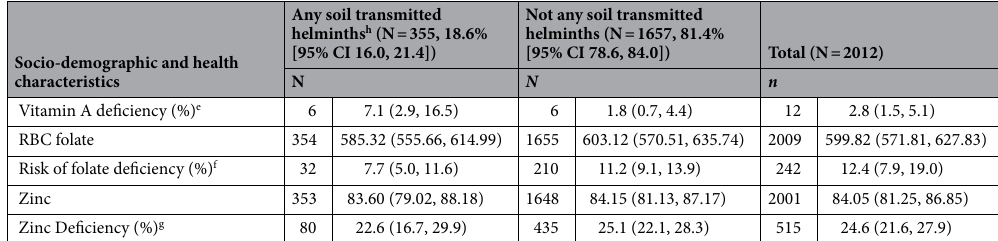
Table 4. Socio-demographic and health characteristics of non-pregnant women aged 15–49 years by status of soil transmitted helminths, Nepal National Micronutrient Status Survey, Nepal, 2016. Ns are unweighted. Values presented are mean (95% CI) or percent (95% CI). All estimates account for weighting and complex sampling design. AGP, ɑ -1 acid glycoprotein; BMI, Body Mass Index; CI, confidence interval; CRP, C-reactive protein; RBC, red blood cell; RBP, retinol binding protein. a Haemoglobin adjusted for altitude and smoking 28 . b Anaemia defined as altitude-and smoking-adjusted Hb < 12.0 g/dL 28 . c Receiving deworming during the 6 months preceding the survey. d Iron deficiency defined as inflammation-adjusted serum ferritin < 15.0 μg/ L 28 . e Vitamin A deficiency was defined as RBP < 0.64 μmol/L 28 . f Folate cutoff based on the risk of megaloblastic